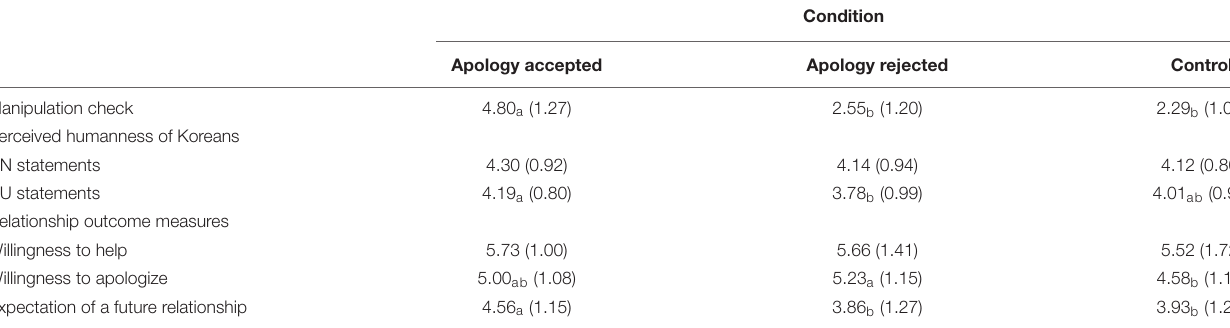
TABLE 5 | Means (standard deviations) of variables in the three experimental conditions (Study